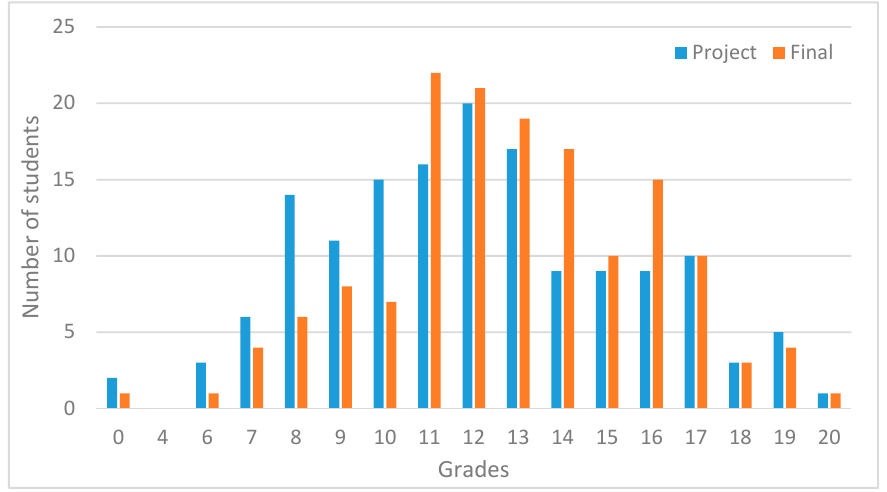
Figure 5. Histogram of the project/final grades.